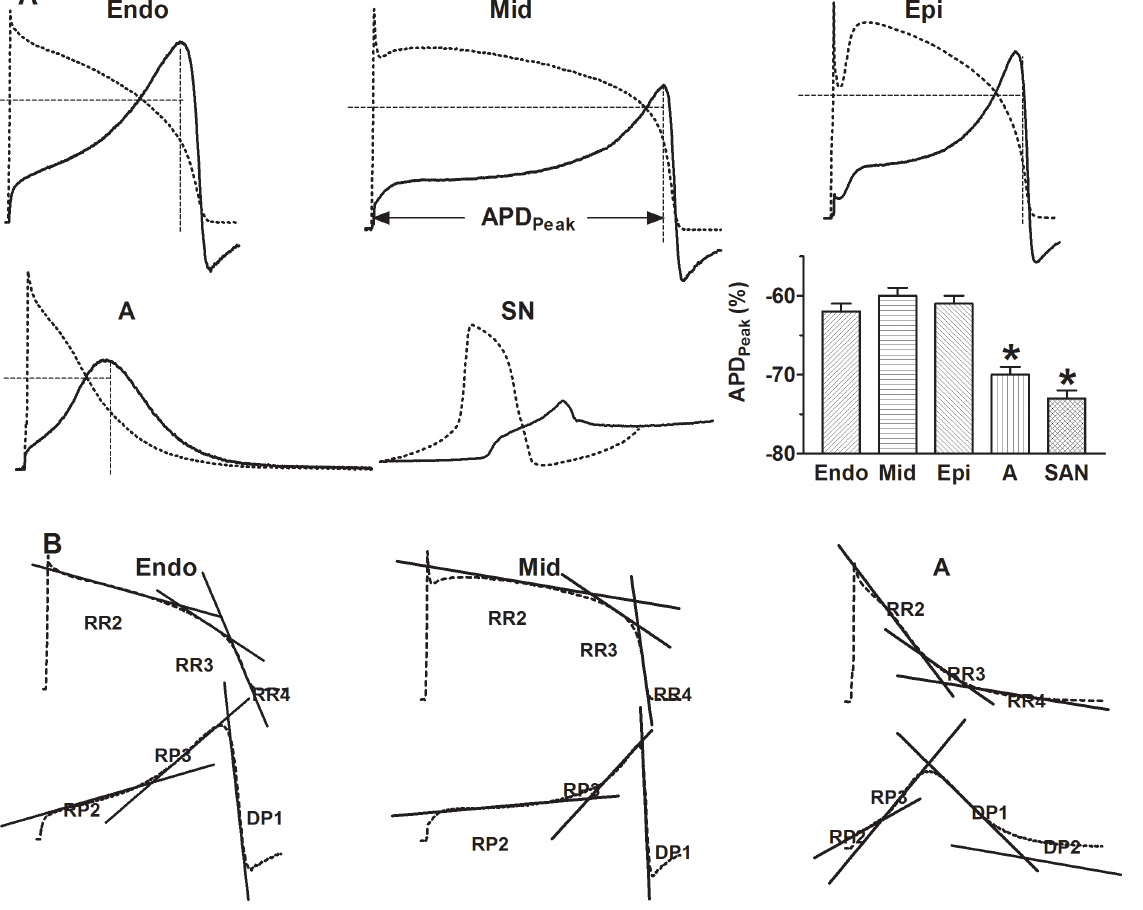
Figure 4. Direct comparison between AP of various regions and the corresponding I HERG waveforms. A , Superimposed AP (dotted line) and I HERG (solid line) traces. Vertical dash lines indicate APD at which I HERG peaks (APD Peak ). Note that the horizontal dash lines pass through the converging point between AP and I HERG and form the boundary for the mirror-image relationship between AP and I HERG . The mean data of APD Peak were averaged from 15 cells for each group. The amplitude and duration scales are the same for all recordings. * p , 0.05 vs. Endo. B , AP and I HERG traces showing the measurements of slopes of various phases by linear regression indicated by the straight lines, as a measure of rate of repolarization for AP and rising/decaying phase for I HERG . RR2, RR3 and RR4, repolarization rate corresponding to the phases of APD 50 , APD 50 -APD 60 and APD 60 -APD 90 , respectively. RP2 and RP3: rising phase 2 and 3 of I HERG trace, respectively; DP1 and DP2: decaying phase 1 and 2 of I HERG trace, respectively.